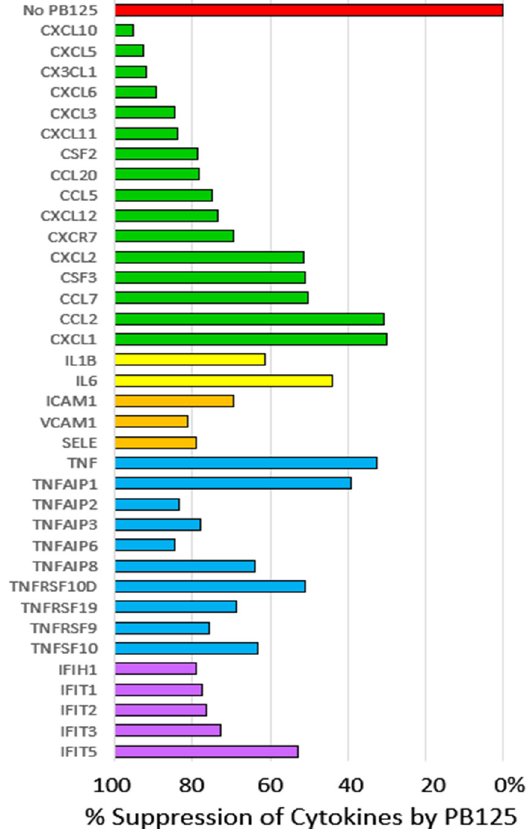
Figure 3. The expression of 36 LPS-induced cytokines in cultured HPAECs was strongly inhibited by PB125 at 5 μ g/mL in culture medium. Control expressions were normalized to 100% expression (0%